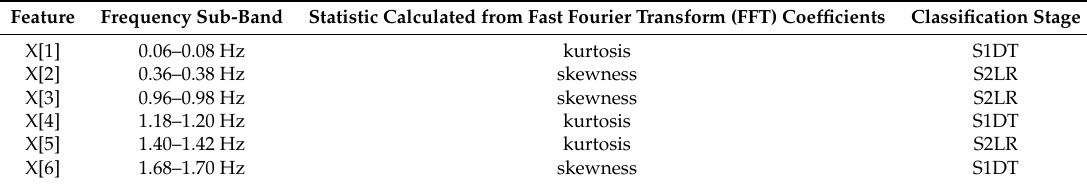
Table 1. Spectral features used for OSA severity classification. S1DT = stage-one decision tree; S2LR = stage-two linear regression